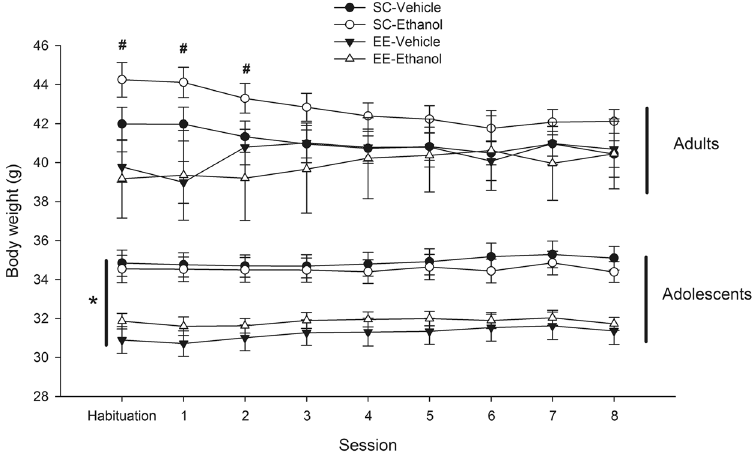
Figure 5. Body weight (g, mean ± SEM) of male Swiss mice, prior to every administration of saline or ethanol (sessions 1 to 8) and prior to the habituation session, as a function of Age (adolescents or adults), Environmental condition (environmental enriched [EE] or standard housing conditions [SC]) and Treatment (4, every-other-day administrations of 0.0 [vehicle control] or 2.0 g/kg ethanol). The asterisk sign indicates that, throughout days, body weight was significantly lower in EE adolescent animals than in SC counterparts. The pound sign indicates a significant difference between EE adults given ethanol and vehicle, SC adults, during habituation and sessions 1 and